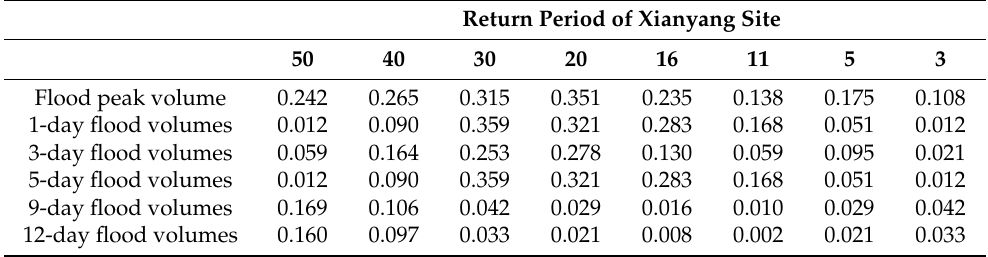
Table 3. KGE values of Zhangjiashan and Huaxian County under various return periods at Xianyang.